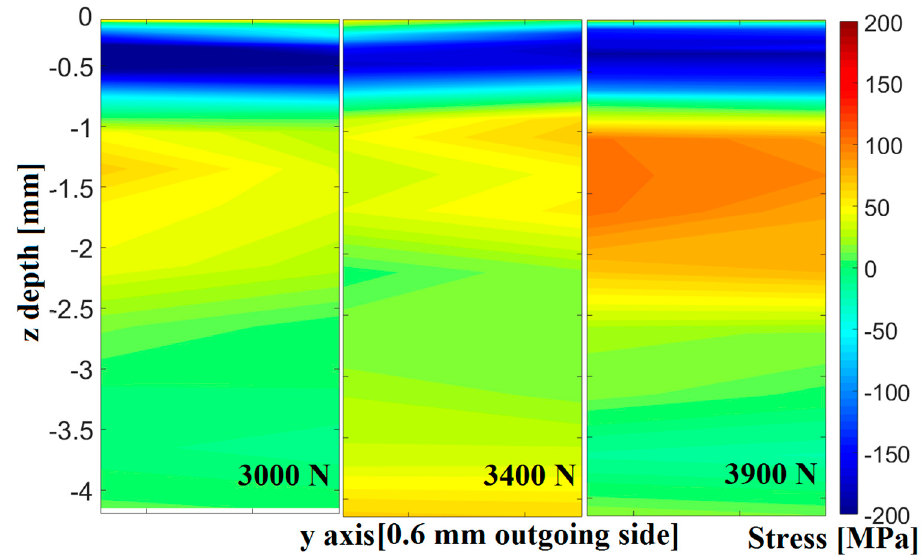
Figure 5. Resulting residual stress of the σ yy component (y = − 3.65mm to − 4.15 mm) for three applied contact forces.